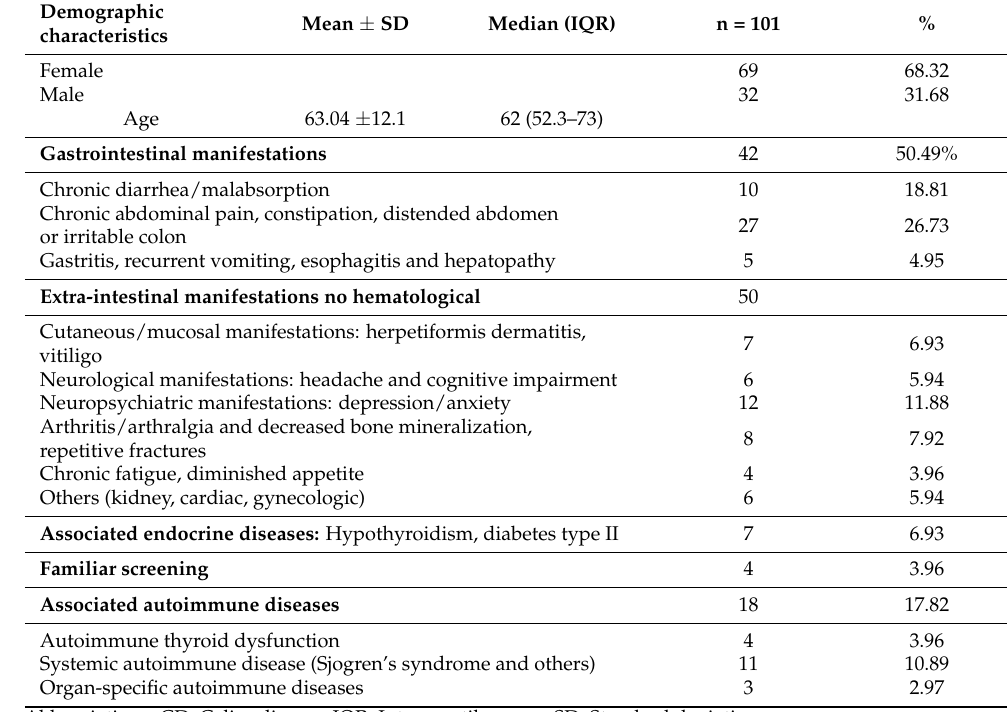
Figure 1. Flow chart of CD diagnosis. Abbreviations: IgA EMA, endomysial IgA antibodies; MCV, Mean cell volume; RDW, Red blood width; TTG2-IgA, Tissue transglutaminase antibody (IgA). Table 2. Clinical and demographic characteristics of patients newly diagnosed with CD.